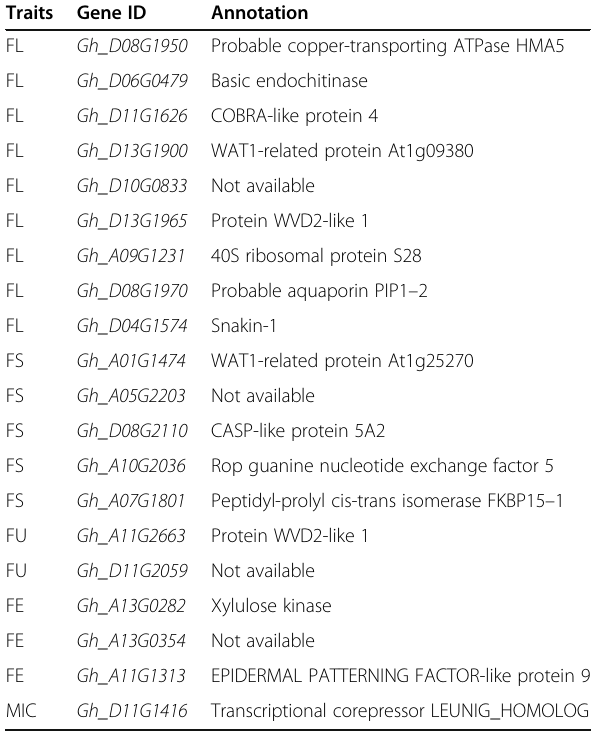
Table 3 The annotation of key candidate